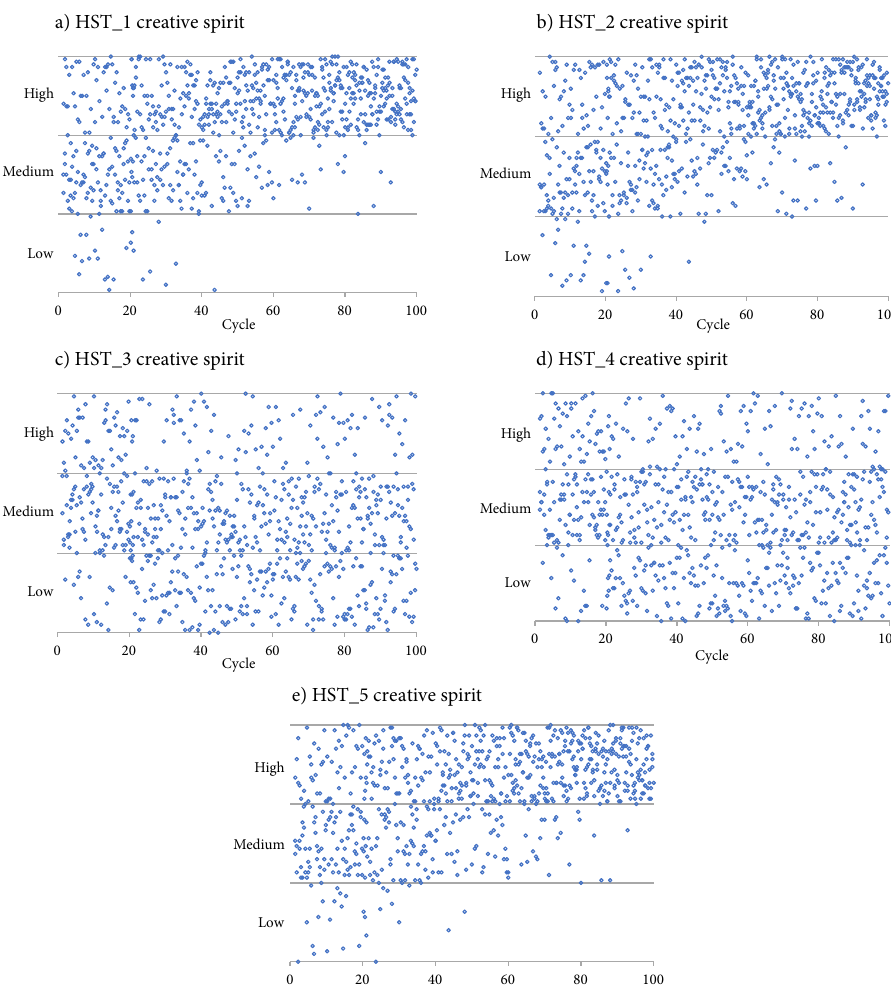
Figure 11. Evolution of entrepreneurs’ innovative spirit in different policy scenarios of high-structured social